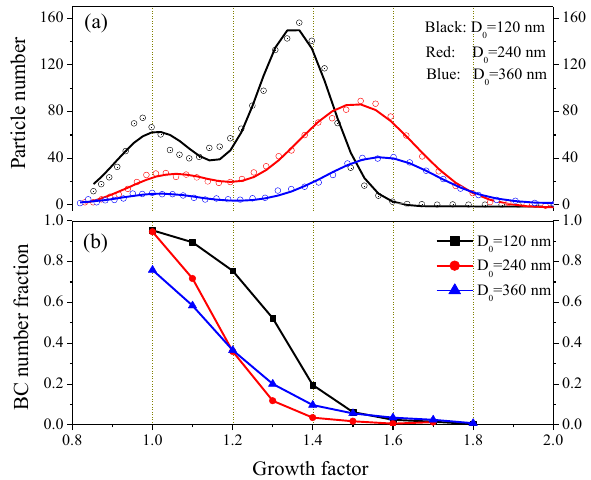
Figure 3. Averaged hygroscopic growth distributions of (a) total ambient particles and (b) BC particles at RH = 85% for three se- lected sizes ( D 0 = 120, 240, and